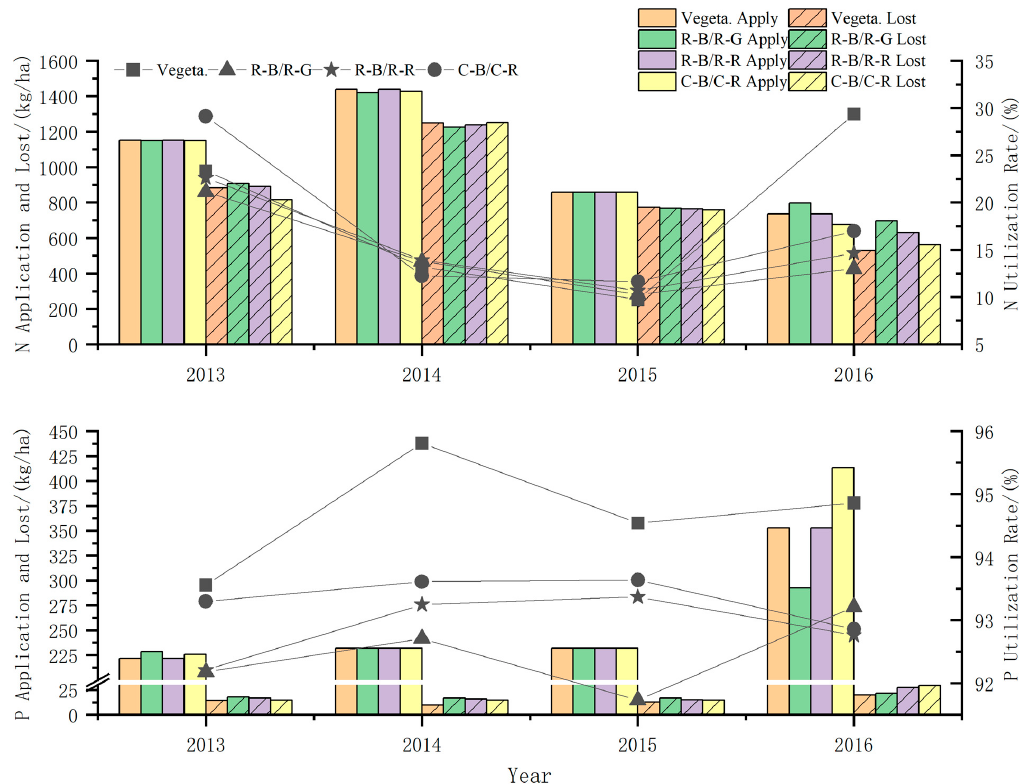
Figure 4. N and P input and utilization in different cropping systems from 2013 to